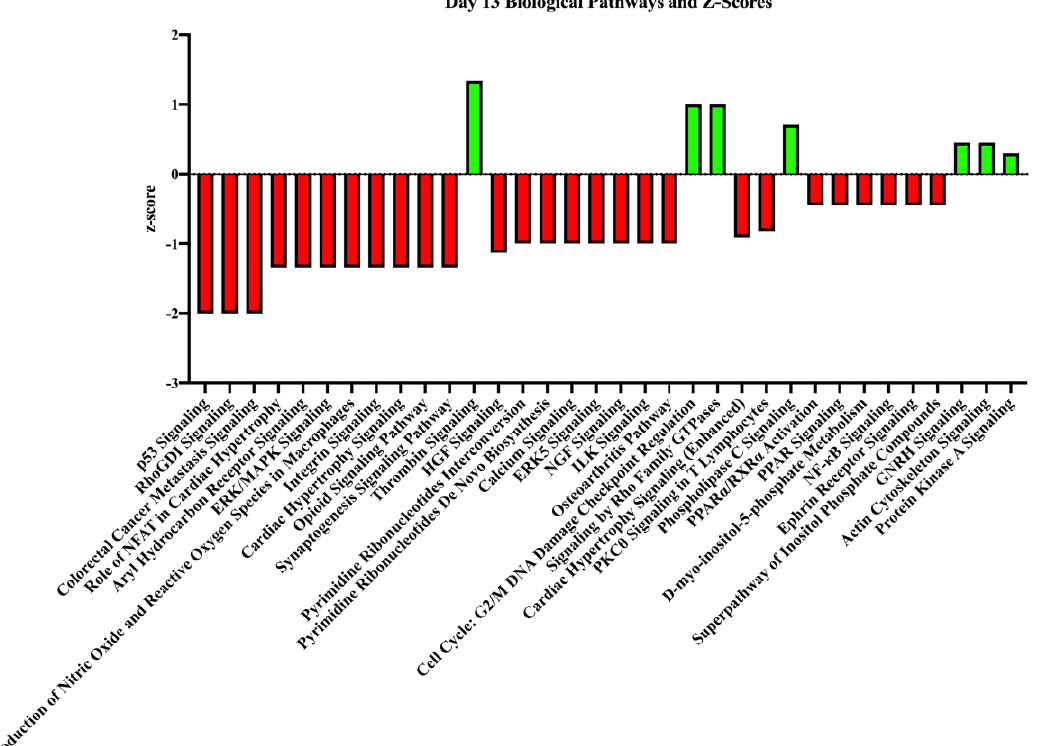
Figure 5. Top biological processes and z-scores on day 13 in endometrial samples from pregnant and non-pregnant mares. These are the biological processes associated with the genes of higher abundance in the given pregnancy status on day 13. The z-score indicates the association strength with activating (green bars) or inhibiting (red bars) a pathway due to the sample being obtained from a pregnant mare.